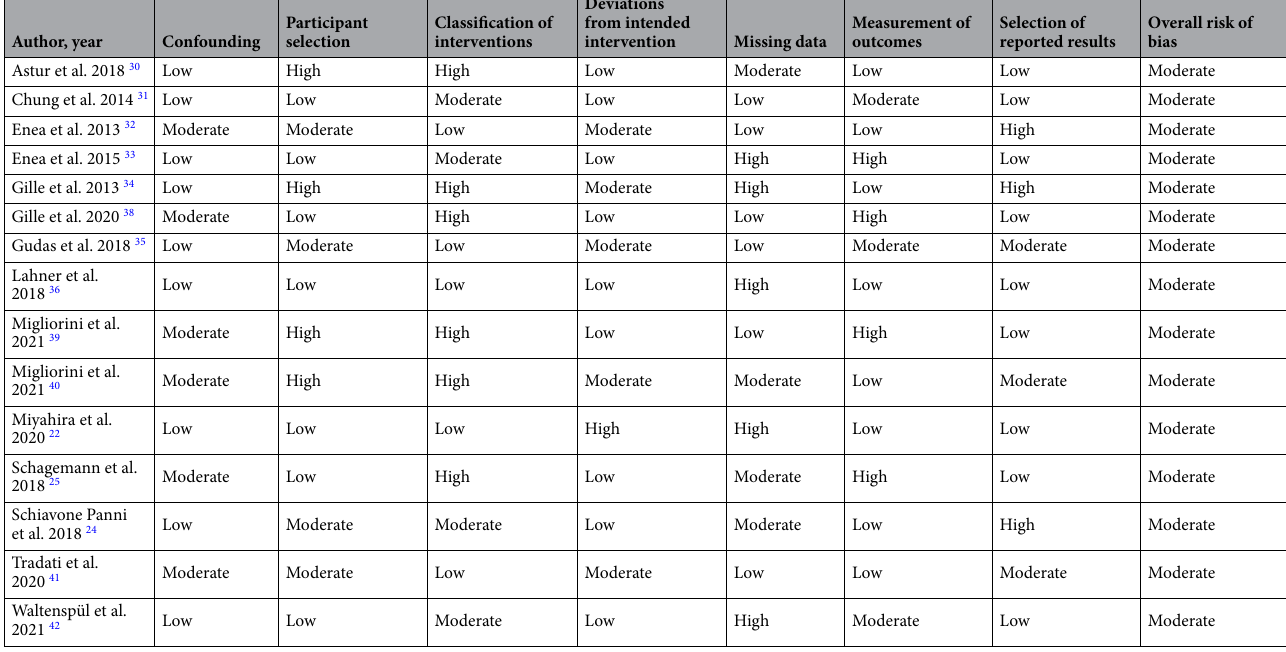
Table 1. The ROBINS-I of